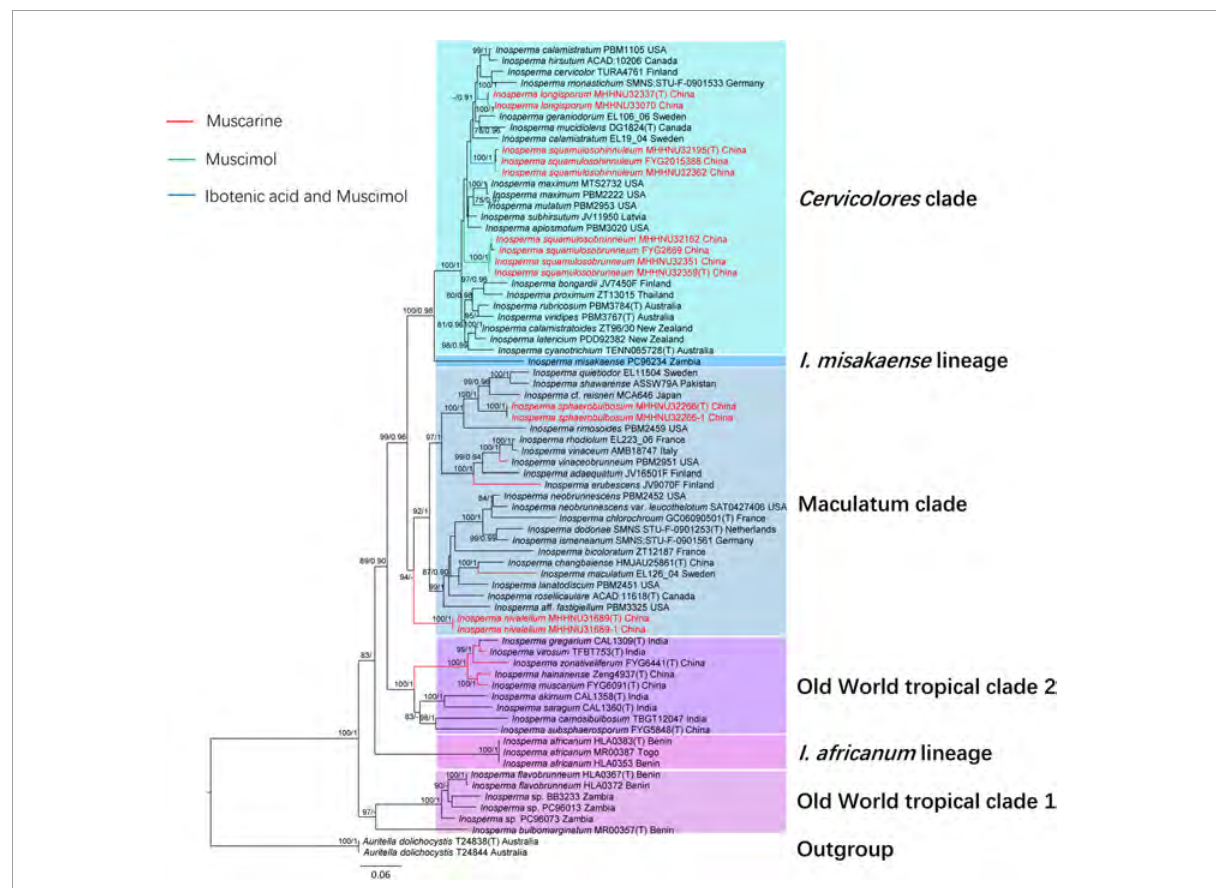
FIGURE1 Phylogenetic relationship and placement of Inosperma inferred from the combined dataset (ITS, nrLSU, and rpb2) using ML and BI phylogenetic methods. Bootstrap values (MLB) ≥ 70% and Bayesian posterior probabilities (BPP) ≥ 0.90 are reported at relevant nodes (ML/BI). The new species are indicated in red. Only the ML tree is shown. Toxins refer to Kosentka et al. (2013), Bijeesh et al. (2020), and Deng et al. (2021a,